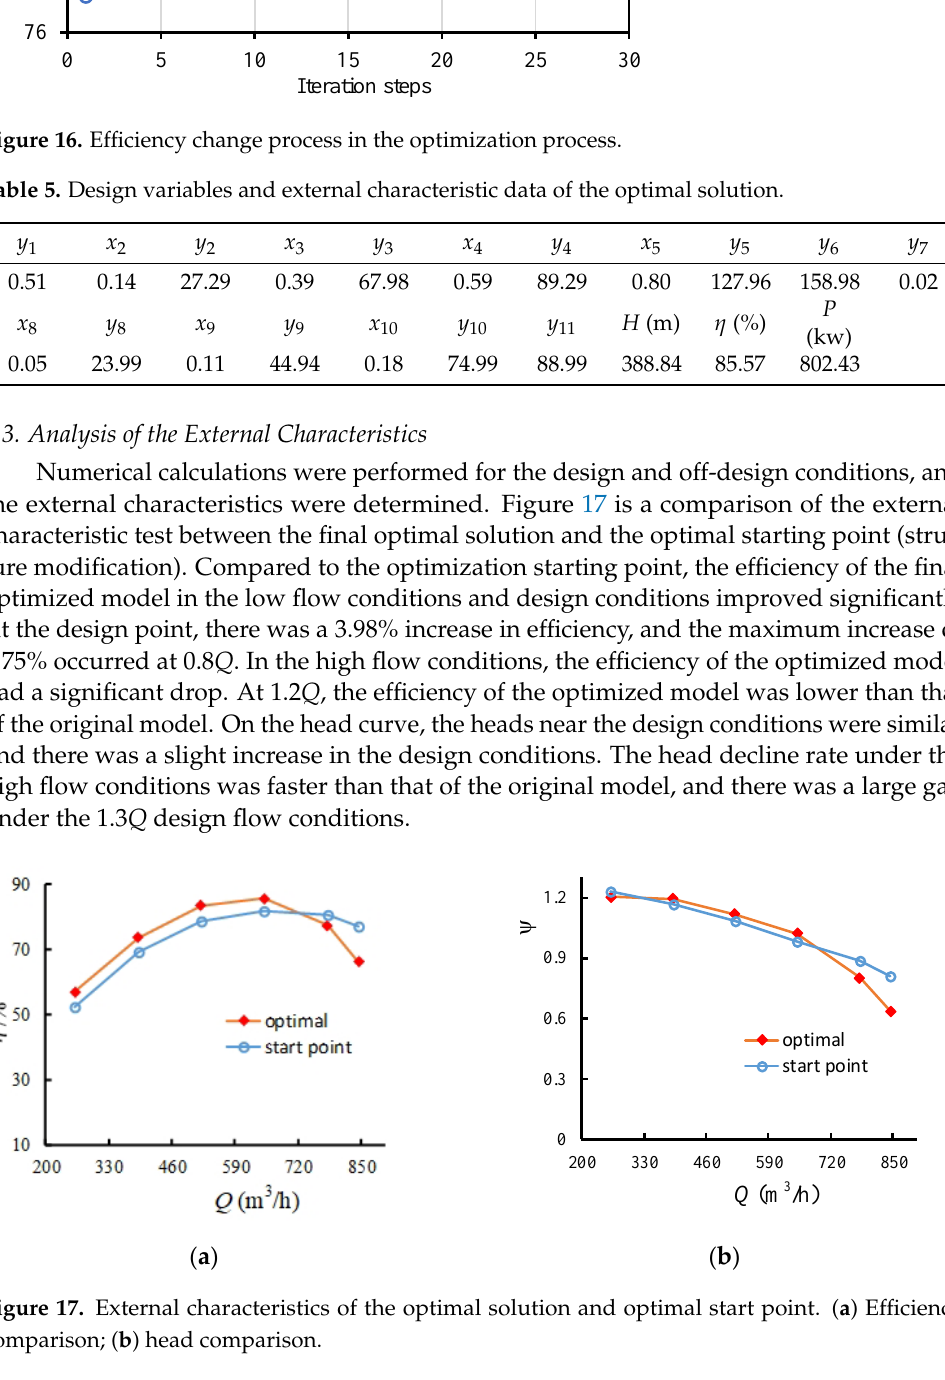
comparison. comparison; ( b ) head